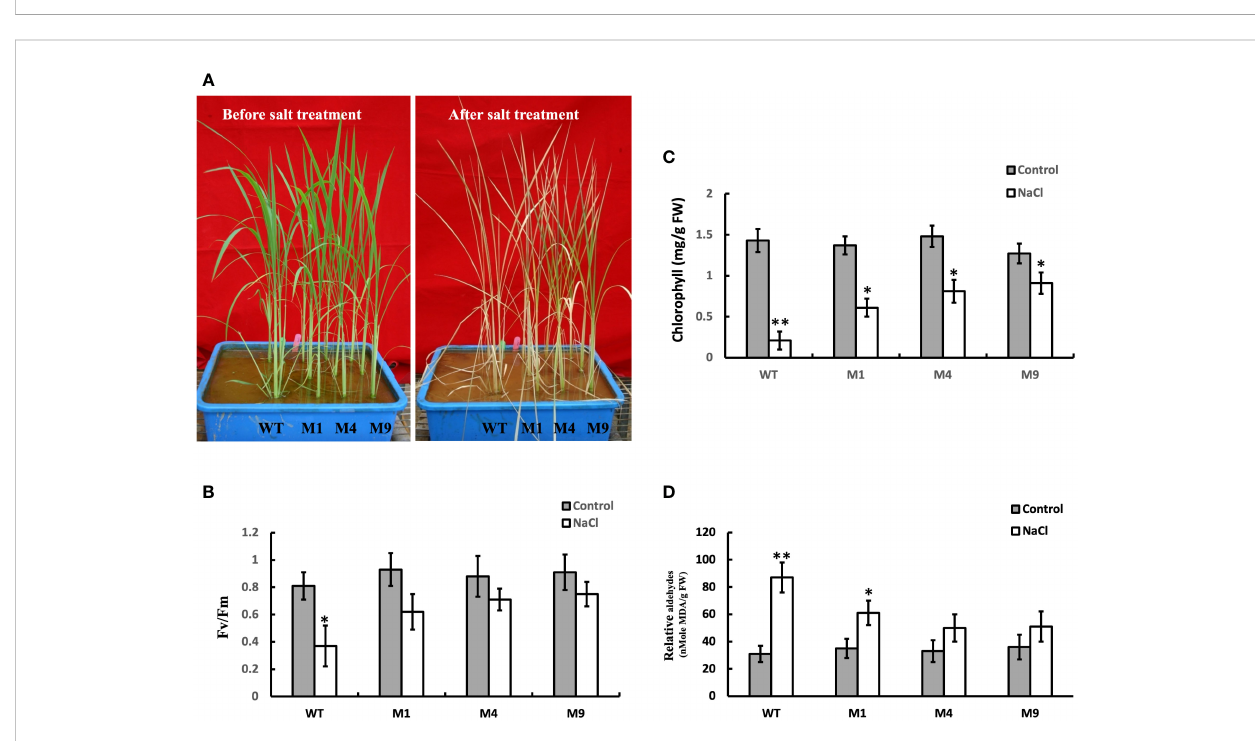
FIGURE 6 Ectopic expression of AtMSRB5 confers rice enhanced tolerance to salt. Forty- fi ve-day-old seedlings, comprising wild-type (WT) and transgenic AtMSRB5 rice (M1, M4, and M9) plants, were grown on soil with or without 250 mM NaCl for 7 days. (A) Photographs of plants before and after salt treatment. (B) F v/ F m ratio, (C) Chlorophyll content, and (D) MDA content, an indication of lipid peroxidation, were determined. Data are means ± SD ( n = 6) of 3 independent experiments and analyzed statistically using student ’ s t test. *, P < 0.05. **, P <